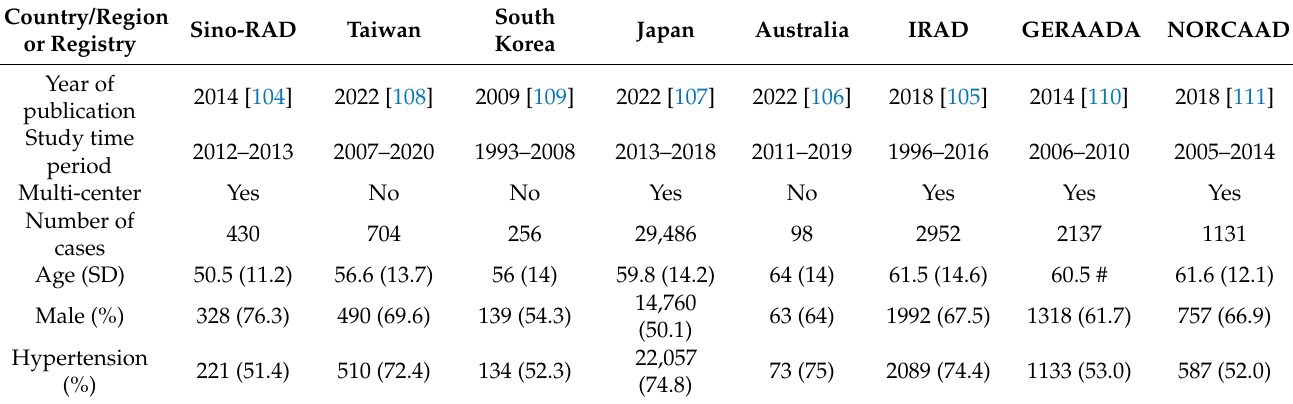
Table 1. General characteristics of type A AAD from Eastern and Western